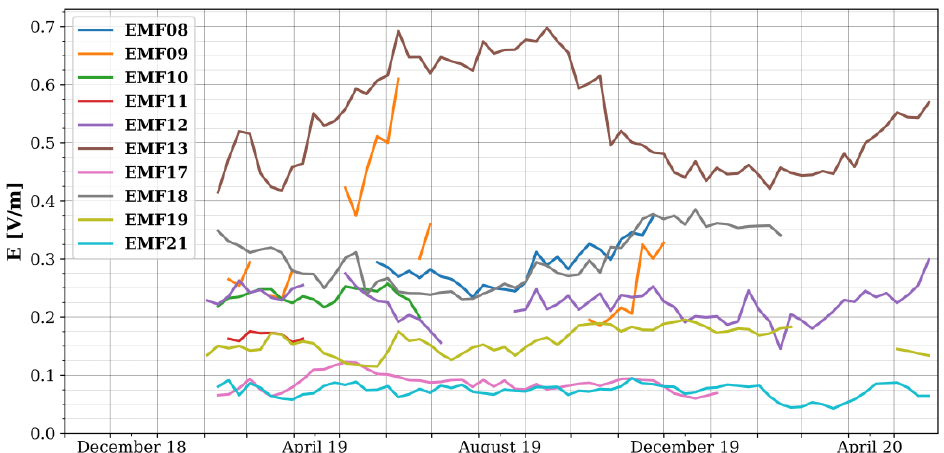
Figure 5. Weekly average electric field strength as measured by the fixed RF-EMF sensors in the 900 MHz frequency band. EMF08 (dark blue) and EMF09 (orange) were not validated in situ.